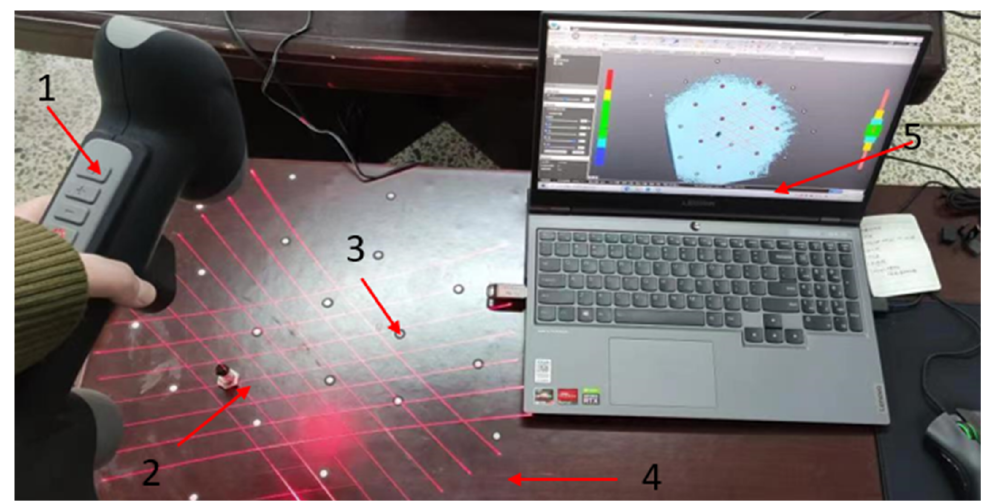
Figure 10. Process diagram of collecting point cloud data on coarse aggregate surface. (1) Laser